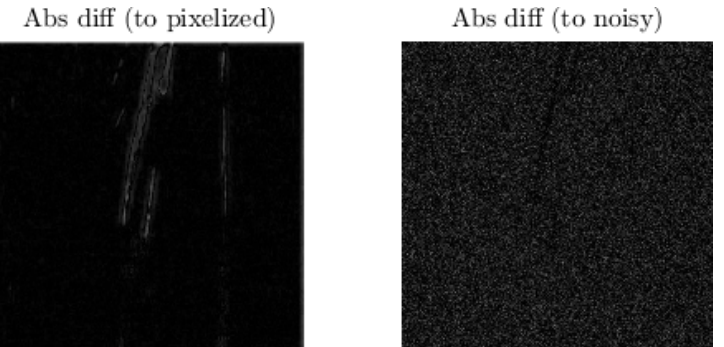
Figure 11. Absolute difference imagesfor seeing how the corruption affected the images (with respect to original image). Images were converted to grayscale first.